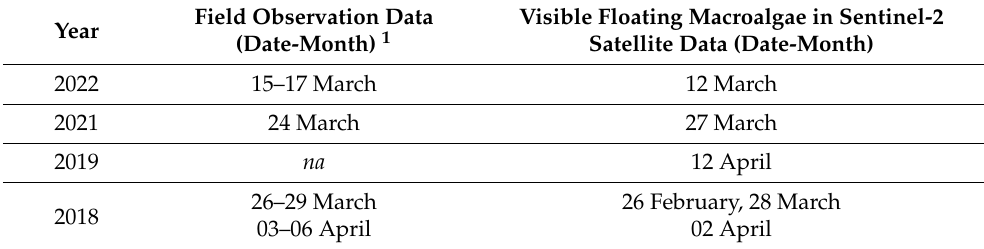
Table 2. Sentinel-2 satellite data of visible floating macroalgae toward datetime of yellowtail larva information in the Kagoshima area [3,4,26].